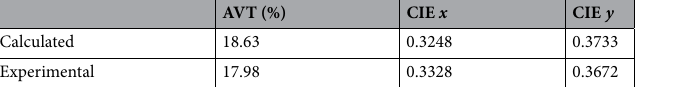
Table 1. Comparison of optical characteristics obtained by experiment and calculation. Calculated and experimental AVT and CIE 1931 color coordinates of ST-OSC/(MgF 2 /MoO 3 ) 4 ST-OSC with λ B = 700 nm PBG.